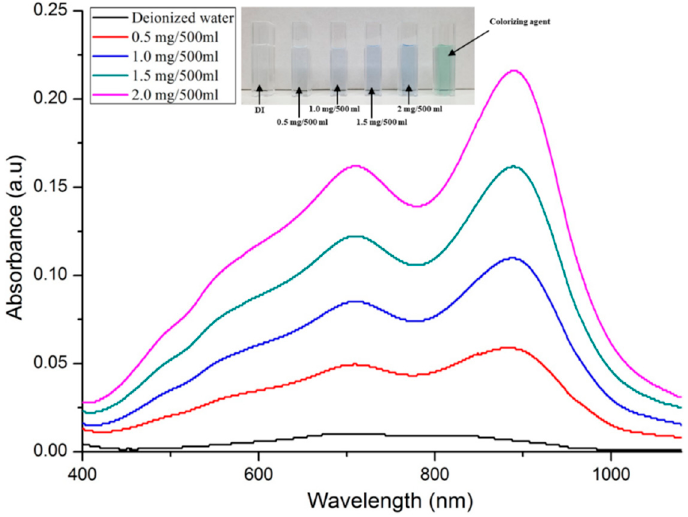
Figure 7. Measured absorbance as a function of the phosphate concentration after pretreatment step by autoclave.